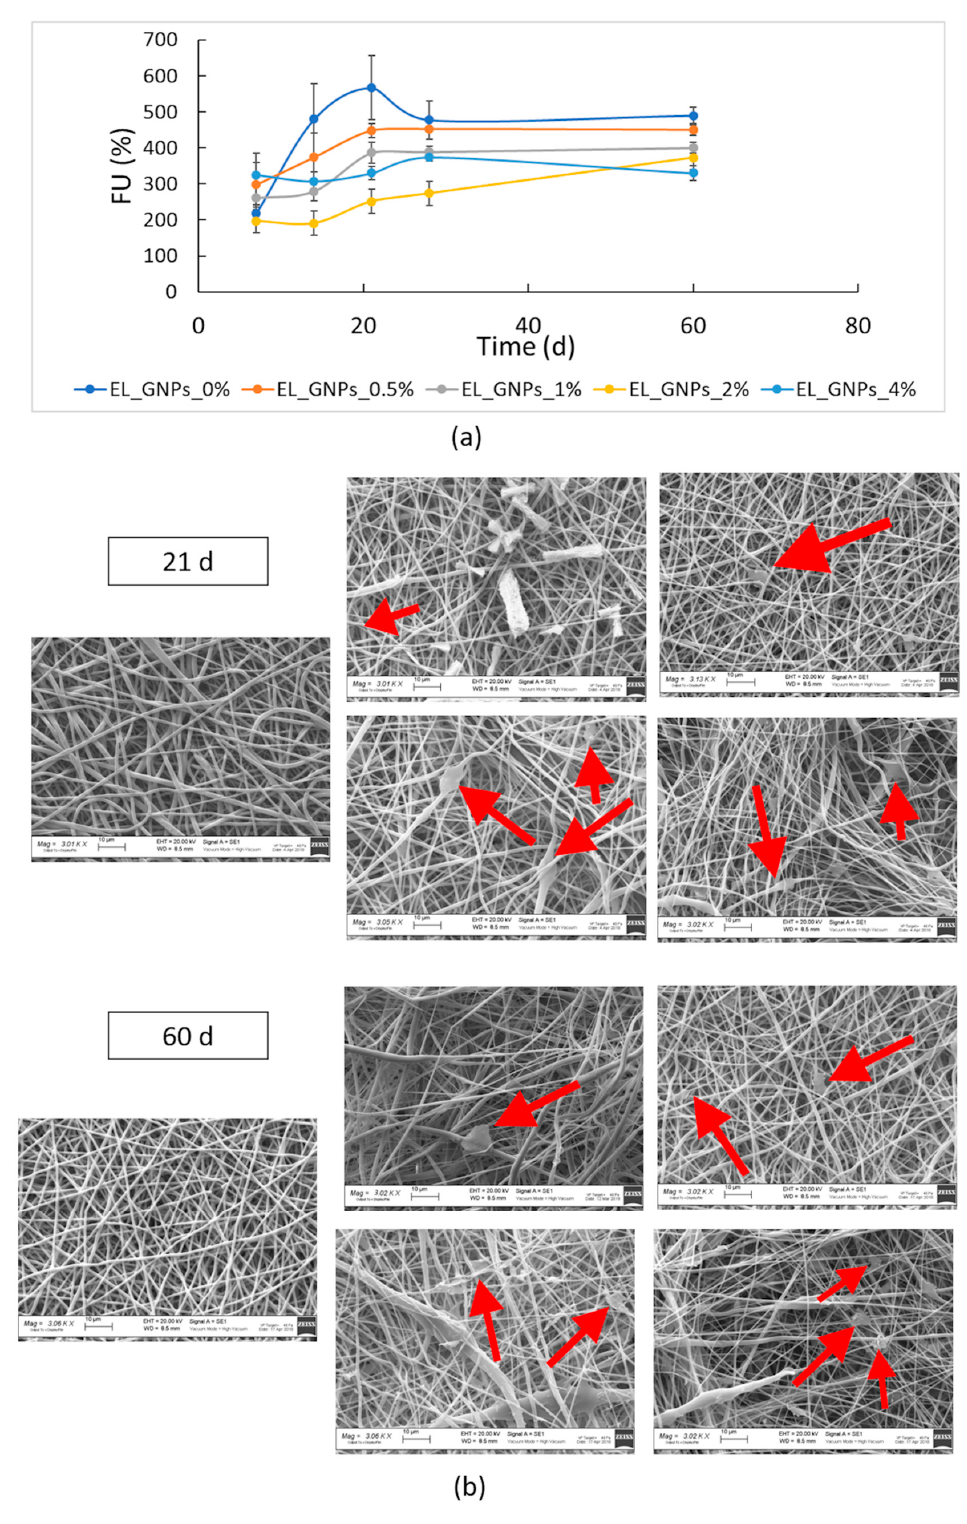
Figure 5. ( a ) Fluid uptake (FU) percentage of neat EL_GNP_0% and EL_GNPs composite matrices during 60d of incubation at 37 °C in 5 mL of DMEM (10% FBS, 1% antibiotics); ( b ) SEM micrographs (3 kX magnification, scale bar 10 µ m) of freeze-dried EL_GNP_0%, EL_GNPs composite matrices after 21d and 60d incubation.